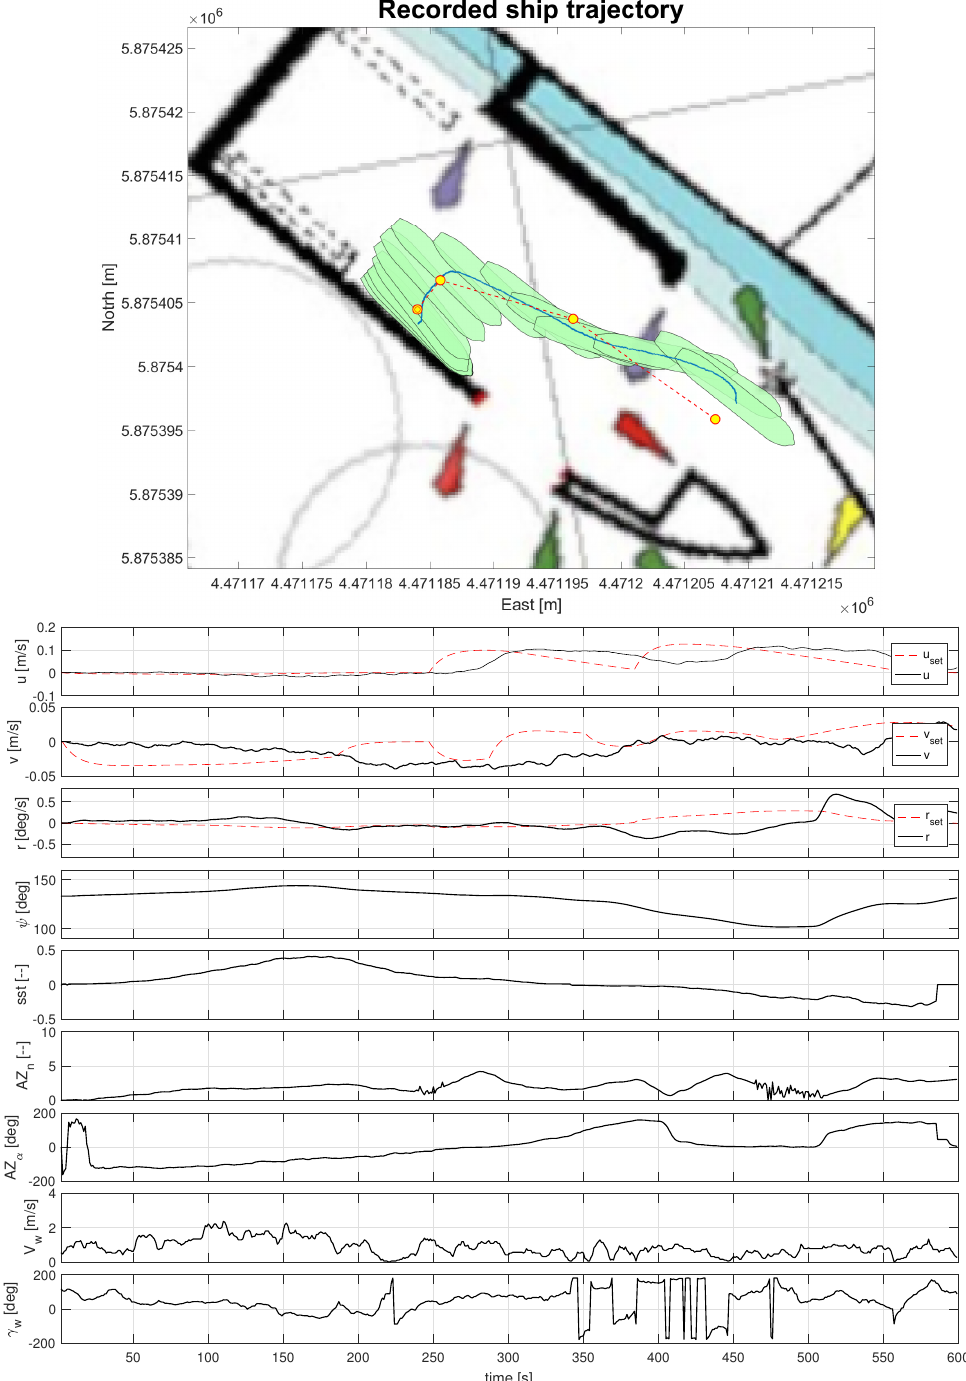
Figure 9. Departure maneuver of the “Dorchester Lady” model from the Iława Port. Upper part: Reference (dashed line) and measured (solid line) trajectories of the training ship. Lower part: recorded signals marked with following symbols: y , v , r —velocities, longitudinal, transversal (“–” sign indicates ship motion to the port side), and rotational (“–” sign indicates counterclockwise rotation), respectively; ψ —heading angle of the ship; sst —bow thruster reference value ( − 1 . . . 1 ) ; AZ n , AZ α —azipods’ thrust reference value ( 1 . . . 10 ) and orientation angle; V w , γ w —velocity and angle of apparent